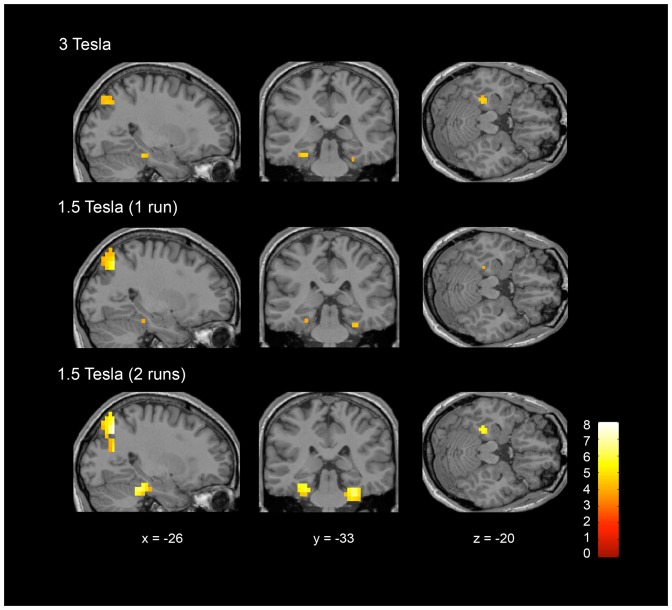
ROI group results showing activation of the parahippocampal cortex and the occipito-parietal junction for the spatial navigation task (i.e. imagine walking around your house) compared to rest at 3T and 1.5T (including 1 and 2 runs).For display, results are thresholded at an uncorrected p<0.001 and rendered on a canonical single subject T1 MRI image.